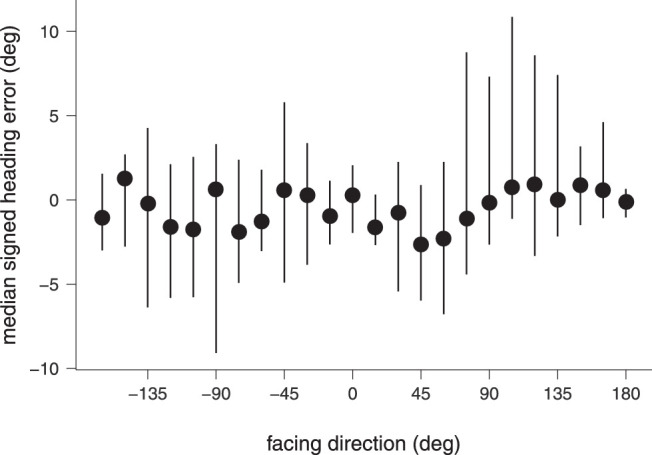
Median signed heading errors in the natural articulation-plus-translation condition for all facing directions. Error bars give the upper and lower interquartile ranges.